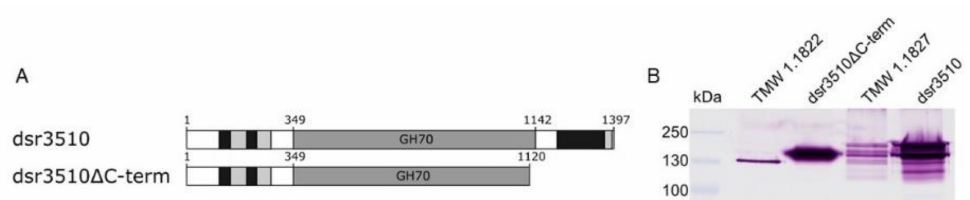
Figure 1. Domain architectures (primary sequences) of the heterologously expressed variants of the L. nagelii TMW 1.1827 dextransucrase. Black = glucan-binding domains, light gray = glucan-binding repeats, dark gray = GH70 catalytic domain ( A ). SDS-PAGE with subsequent activity staining of het- erologously expressed dextransucrase variants compared to the native extracellular dextransucrases of L. hordei TMW 1.1822 and L. nagelii TMW 1.1827 ( B